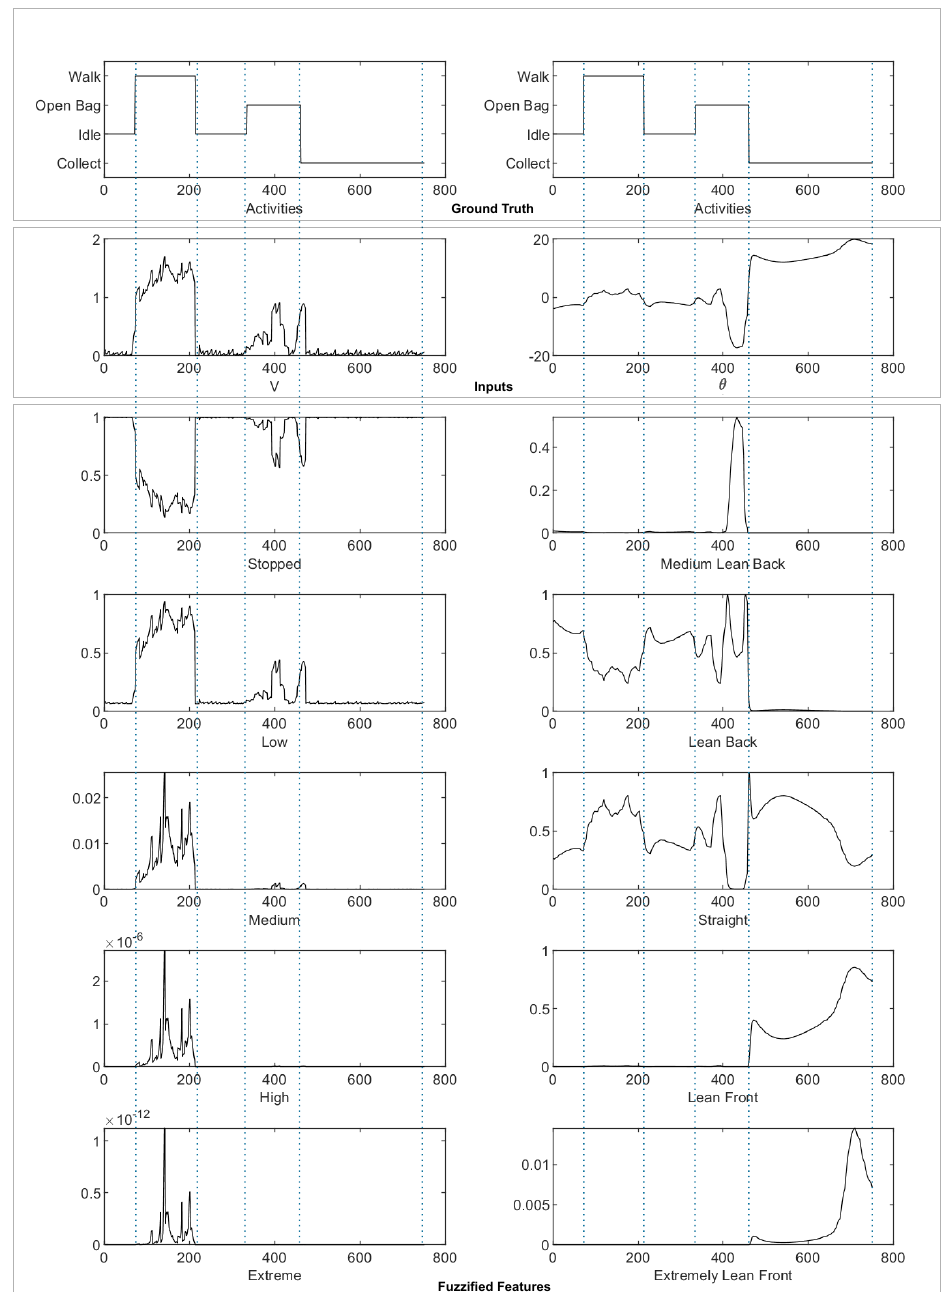
Figure 7. Motion and Tilt plotting along an activity